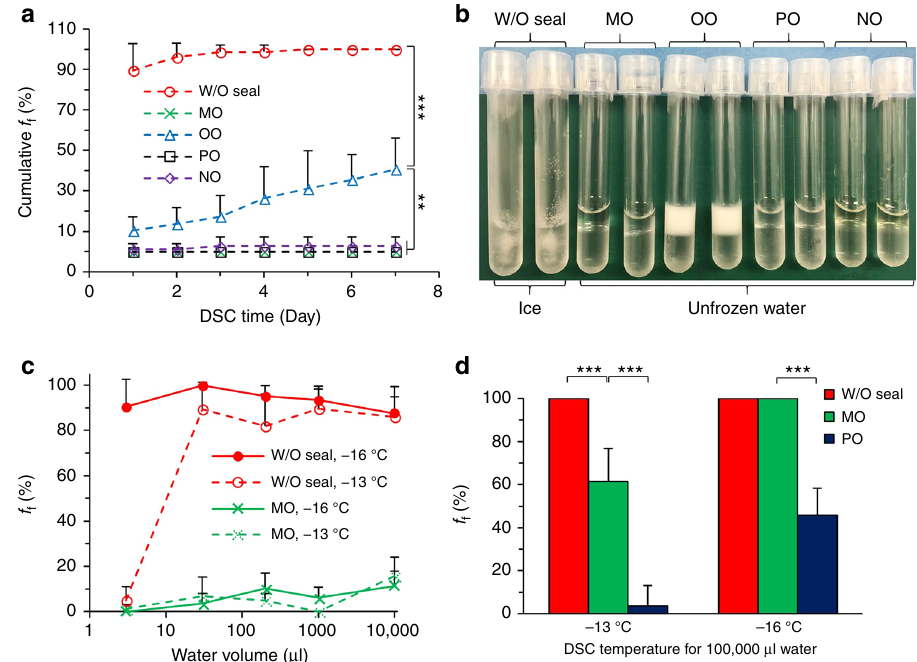
Fig. 1 Deep supercooling of pure water enabled by surface sealing with oils. a Cumulative freezing frequency ( f f ) for 1 ml water at − 13 °C over 7-day deep supercooling (DSC), without sealing (W/O seal), with surface sealing by light mineral oil (MO), olive oil (OO), heavy paraf fi n oil (PO), and nutmeg oil (NO). Number of independent experiments n = 6, number of total tested samples for each case N = 56. NS: p > 0 .05; *0.005< p < 0.05; **1.0 × 10 − 6 < p < 0.005, *** p < 1.0 × 10 − 6 . b Corresponding samples of ( a ) post 1-day storage. c f f of DSC water of various volumes post 1-day storage at − 13 and − 16 °C. n = 7, N = 272, 145, 336, 123, and 125 for 3, 30, 200, 1000, and 10000 μ l water, respectively. d f μ l water with different sealing oils and f of 100,000 temperatures post 1-day storage, n = 7, N = 35. Error bars represent standard